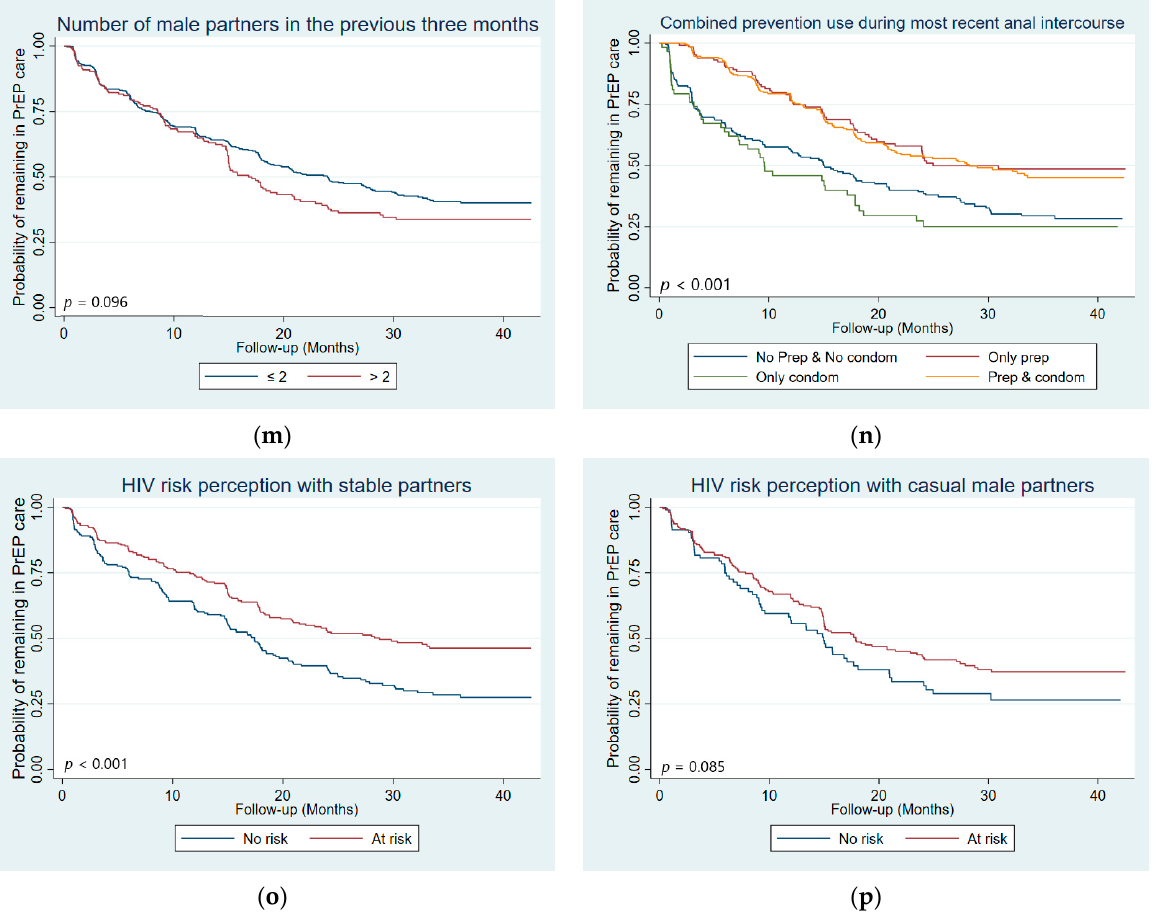
Figure 2. Kaplan–Meier curves with log-rank test p -value comparing LTFU by: ( a ) age group, ( b ) country, ( c ) employment status, ( d ) recruitment type, ( e ) chosen PrEP regimen, ( f ) PrEP adherence, ( g ) contact with peer educators outside of scheduled visits, ( h ) self-defined sexual orientation, ( i ) self-defined gender identity, ( j ) depression score, ( k ) had a casual male sexual partner in the previous three months, ( l ) had a casual female sexual partner in the previous three months, ( m ) number of male sexual partners in the previous three months, ( n ) Combined prevention use during most recent anal intercourse, ( o ) HIV risk perception with stable male partner, and ( p ) HIV risk perception with casual male partners ( n = 647 participants, 4831 visits). Table 2. Determinants of loss to follow-up from PrEP care ( n = 647 participants, 4831 measures) 1 . Univariate